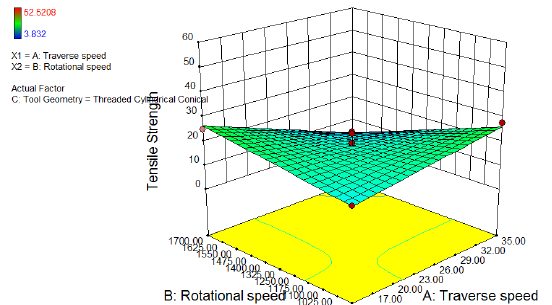
Fig. 12: 3D-Graph Interaction of Traverse Vs Rotational Speed for Tensile Strength with a Threaded Cylindrical Conical Tool